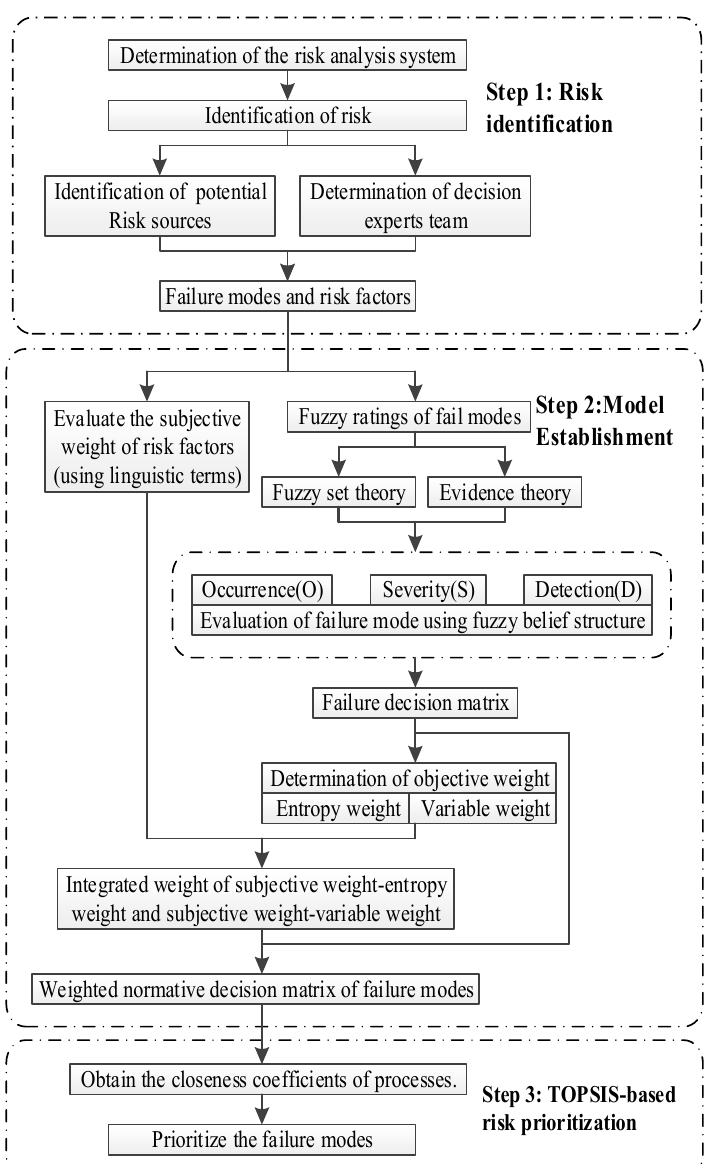
Figure 2. Flowchart of the proposed approach.